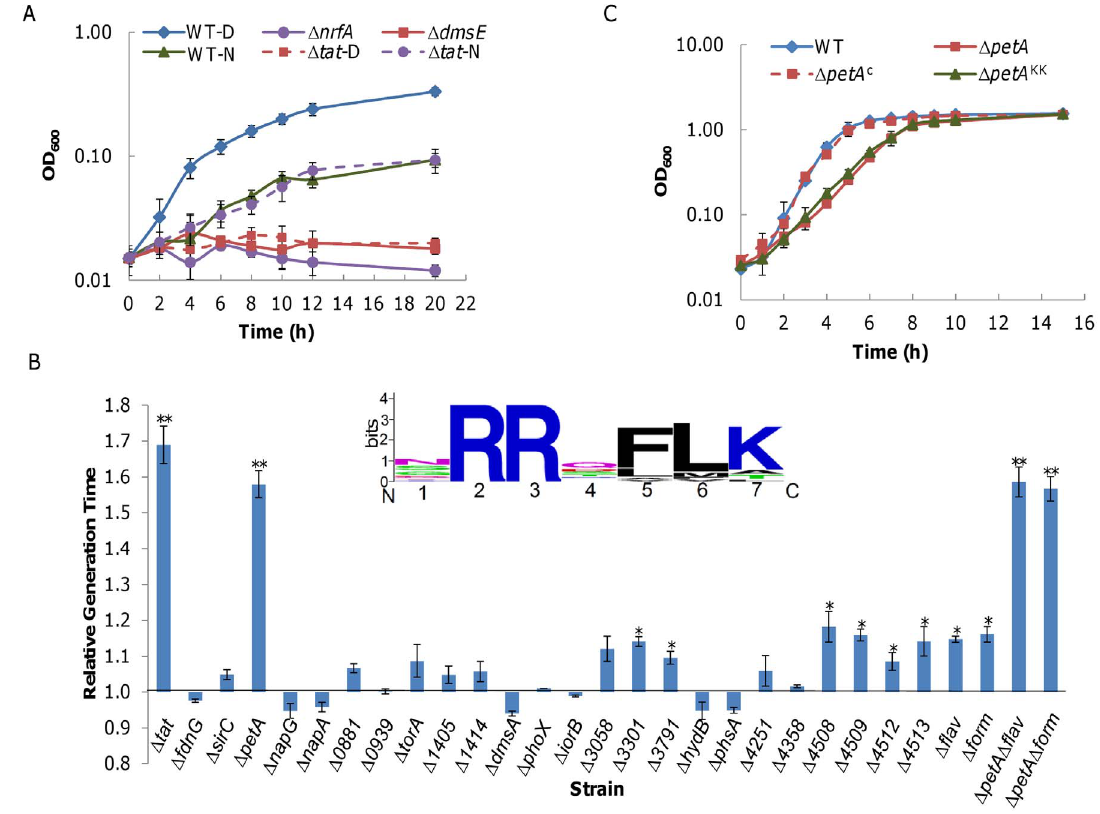
Figure 4. Characterization of mutants lacking one of Tat substrates in S.oneidensis . A. Growth of the wild type, D tat , D nrfA , and D dmsE with DMSO (D) or nitrite (N) as the sole electron acceptor under anaerobic conditions. B. Growth of S. oneidensis mutants lacking one of Tat substrates. Generation time of each strain was deduced from the early exponential phase ( , 0.1 to 0.4 of OD 600 ) and normalized to that of the wild type. Generation time of wild type is defined as 1.00. The single asterisk ( p , 0.05) and double asterisk ( p , 0.01) indicate significant difference in growth rate when compared to the wild type. The consensus motif in signal peptides of the 24 predicted Tat substrates prepared with WEBLOGO version 2.8.2 (http://weblogo.berkeley.edu) was shown. C. Growth of the wild type, D tat , D petA , and D petA complemented by pHG101 containing the wild type petA ( D petA c ) or mutant petA ( D petA KK ) under aerobic conditions. petA KK encodes a protein whose conserved RR within the consensus motif of signal peptides was replaced by KK. Growth assays were performed at least three times, with the error bars representing the standard